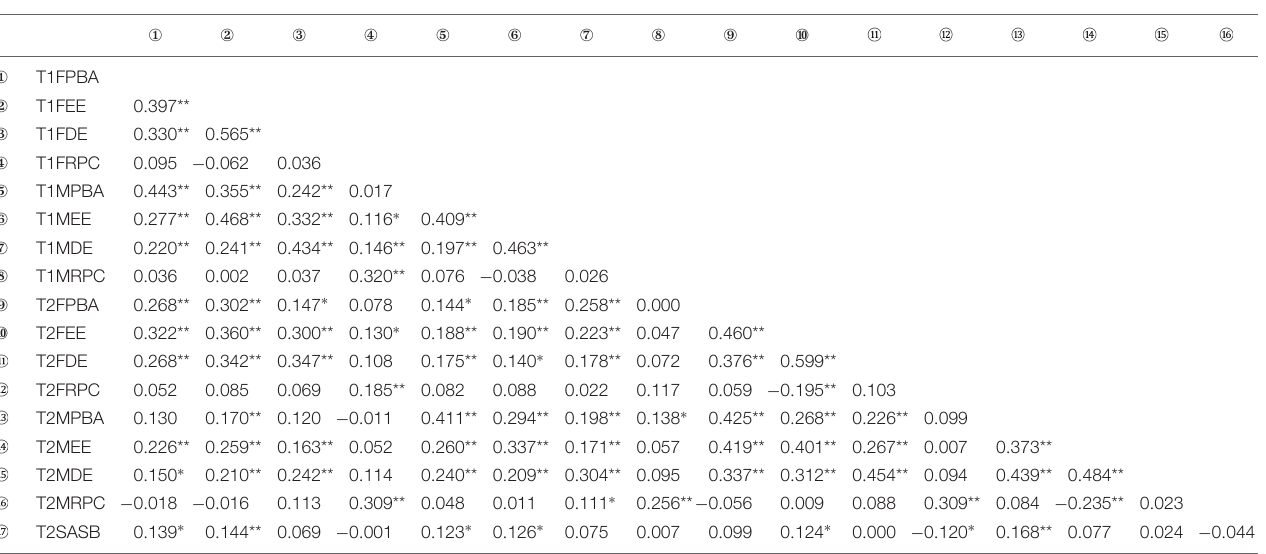
TABLE 5 | Results of the correlation analysis with data collected at both Time 1 and Time